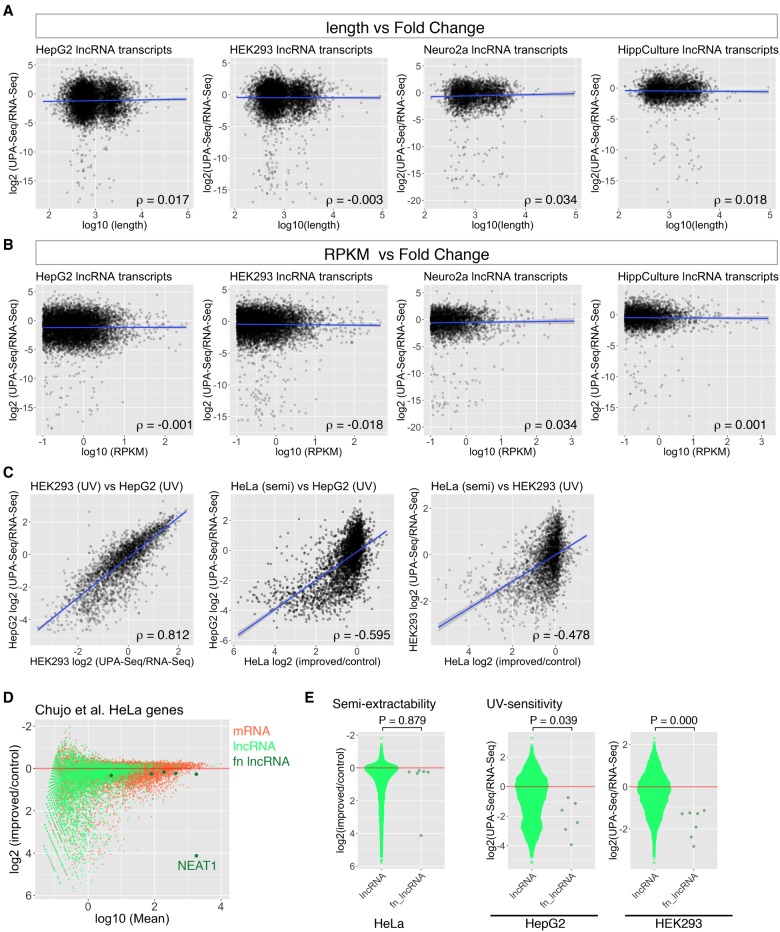

Correlation analysis of fold change of reads upon UV irradiation and the length, RPKM, and semi-extractive properties of lncRNAs. (A,B) Scatter plots illustrating the relationship between the length (A) or RPKM (B) of lncRNAs and the fold change of reads upon UV irradiation in HepG2, HEK293, Neuro2a, and HippCulture cells. Correlation coefficient (ρ) was calculated by Spearman's rank correlation analyses. Note that the length or RPKM did not exhibit a correlation with the fold change of reads upon UV irradiation. Blue lines represent regression lines. (C) Scatter plots illustrating the relationship between the fold change of reads in two different cell types (HEK293 [UV], HepG2 [UV]) and the fold change of reads after improved extraction (HeLa [semi]) compared with the fold change of reads upon UV irradiation (HepG2 [UV], HEK293 [UV]). Note that the y-axes HeLa (semi) showing the fold change of reads after improved extraction are reversed. Correlation coefficient (ρ) was calculated by Spearman's rank correlation analyses. Blue lines represent regression lines. (D) MA-plot of log2 fold change of reads upon improved extraction as a function of the relative abundance (log10 baseMeans) calculated by DESeq2 with an inverted y-axis. Light green dots represent lnRNAs, coral dots represent mRNAs, and dark green dots represent known functional lncRNA genes (fn lncRNA). Note that the extraction of NEAT1 is dramatically enhanced by the improved extraction, whereas other representative functional lncRNAs exhibited only mild, if any, enhancement. (E) Quasi-random beeswarm plots of log2 fold change of reads upon improved extraction (semi-extractability) and UV irradiation (UV sensitivity). Cell types used are indicated at the bottom of the plot. P-values are calculated by Wilcoxon rank sum test. Note that the y-axis for the semi-extractability in HeLa cell is reversed.